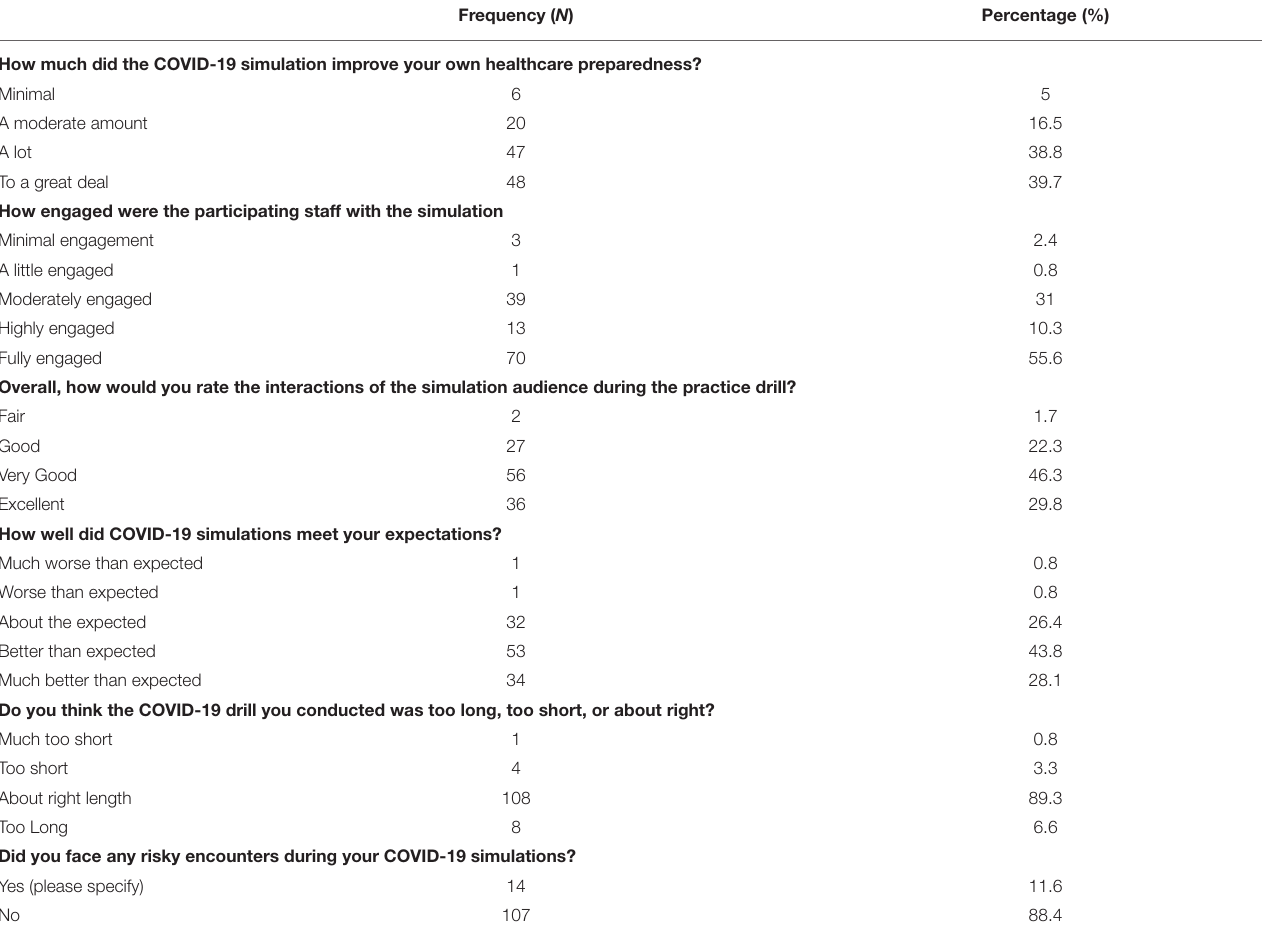
TABLE 3 | Participants’ perceptions and attitudes about their institutions’ COVID-19 simulation